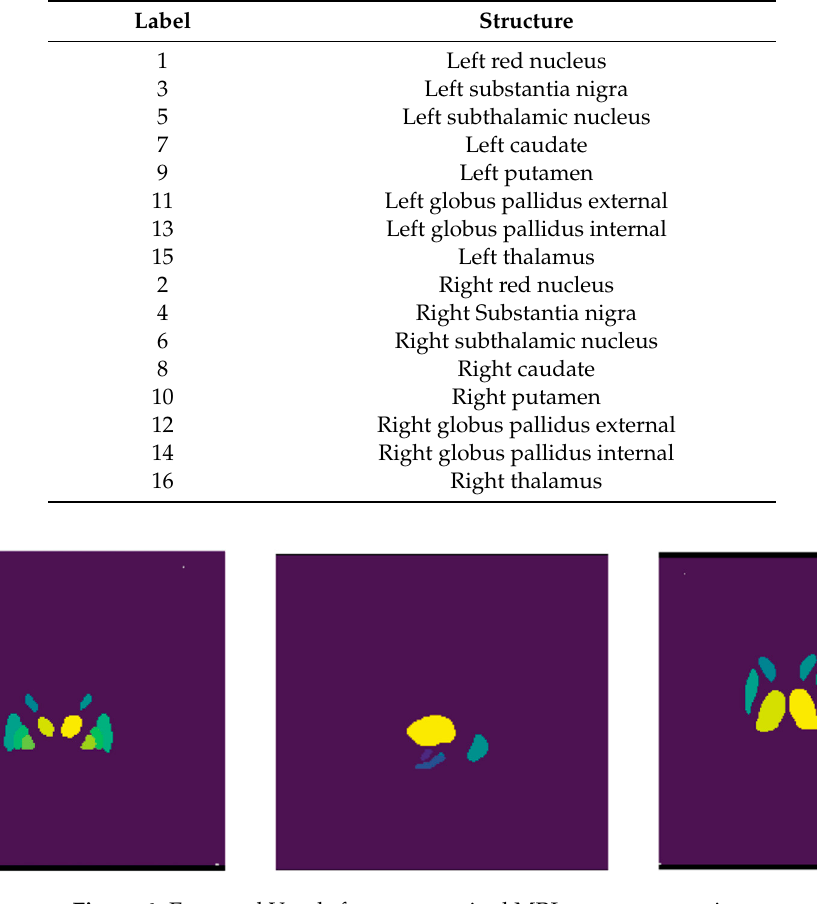
Figure 6. Extracted Voxels from an acquired MRI post segmentation.